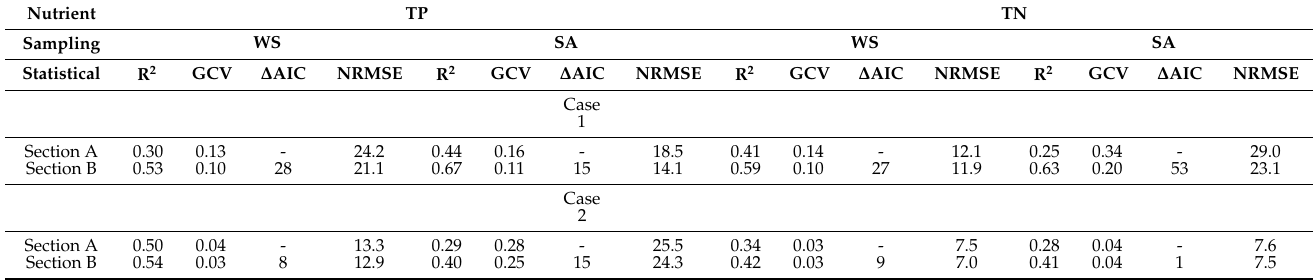
Table 5. Generalized additive model (GAM) for total nitrogen (TN, µ g/L) and total phosphorus (TP, µ g/L) in Case 1 (Canelones) and Case 2 (Laguna del Sauce), for sections A (drainage basin) and B (drainage basin + in-stream), in winter– spring (WS) and summer–autumn (SA). Correlation between predicted and response values (R 2 ) is presented, Generalized Cross-Validation (GCV) coefficient, the difference between models including sections A and B according to Akaike’s Information Criterion ( ∆ AIC), and normalized root mean square error (NRMSE) as a percentage (%). Nutrient TP TN